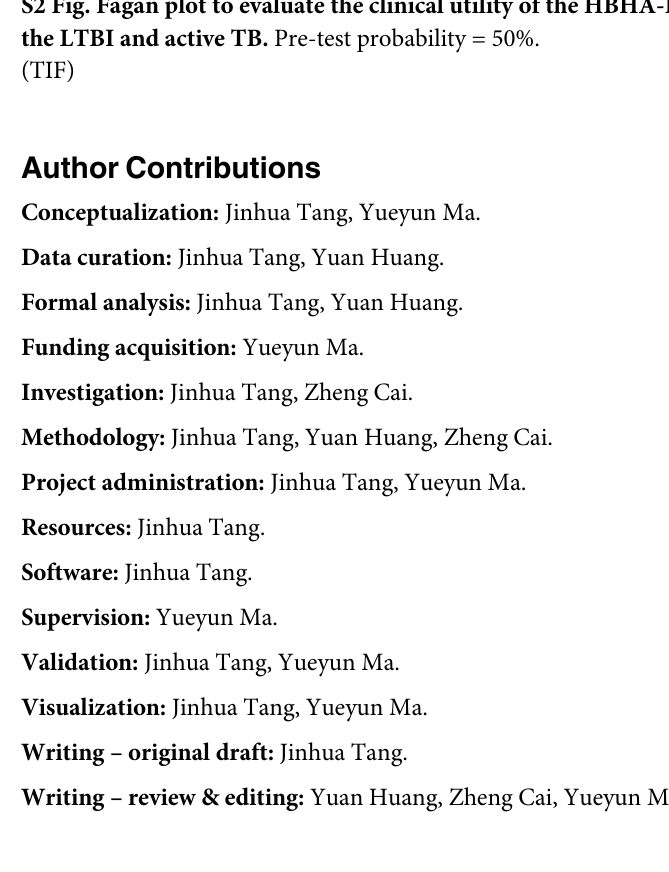
S1 Fig. Meta-analysis estimates of diagnostic odds ratio (DOR) of the HBHA-IGRA for discrimination of the LTBI and active TB, through deleting each study one by one. S2 Fig. Fagan plot to evaluate the clinical utility of the HBHA-IGRA for discrimination of the LTBI and active TB. Pre-test probability =